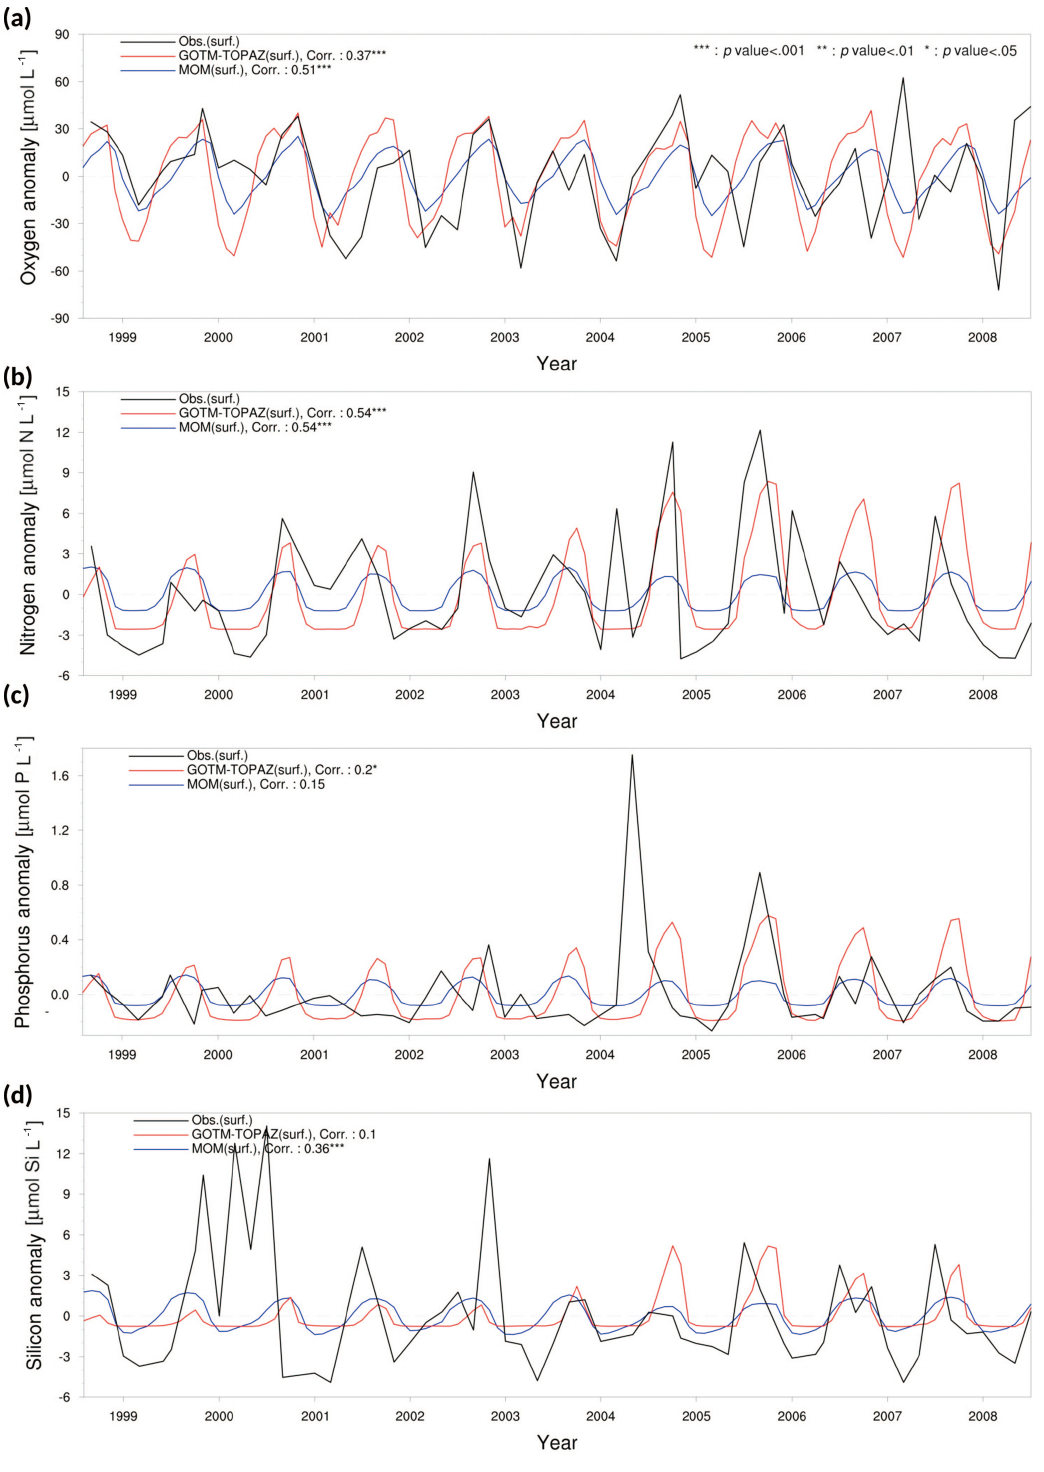
Figure 6. Anomaly time series and correlation values from observational data (black lines), MOM results (blue lines), and GOTM–TOPAZ results (red lines) for concentrations of (a) dissolved oxygen, (b) nitrogen, (c) phosphorus, and (d) silicon at point 104 for the 10-year period of 1999–2008; in this figure, nitrogen, phosphorus, and silicon include NO 3 , PO 4 , and SIO 4 ,